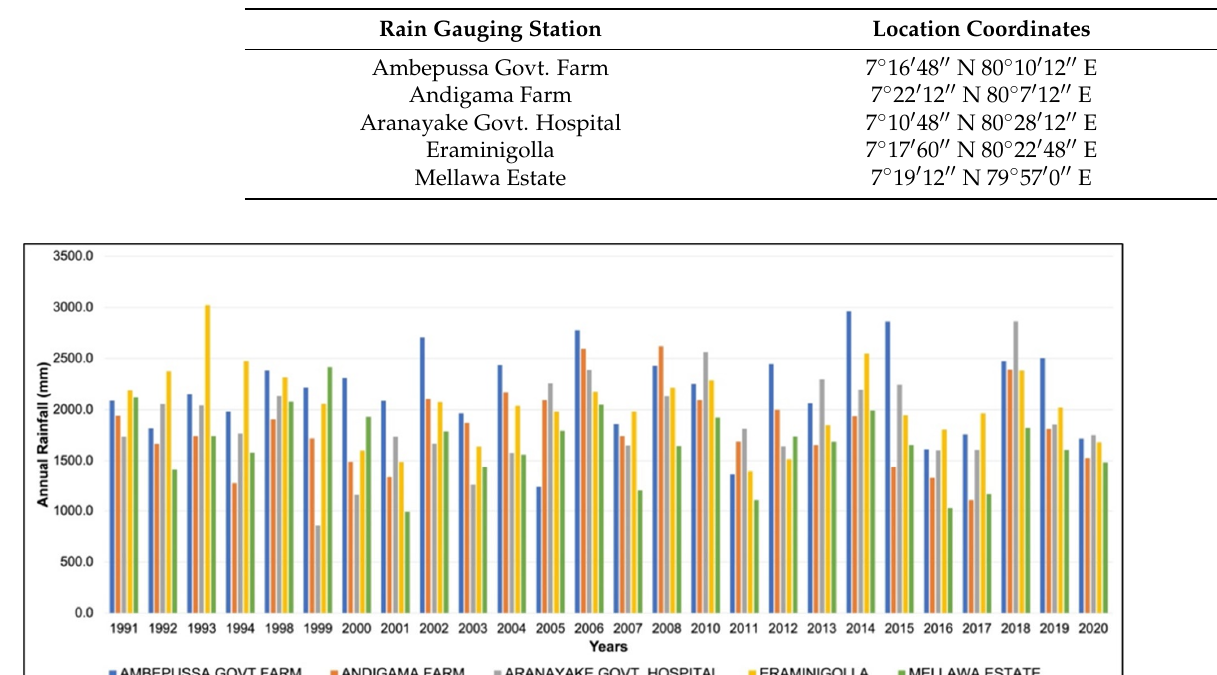
Figure 2. Annual precipitation in the Maha Oya River Basin.